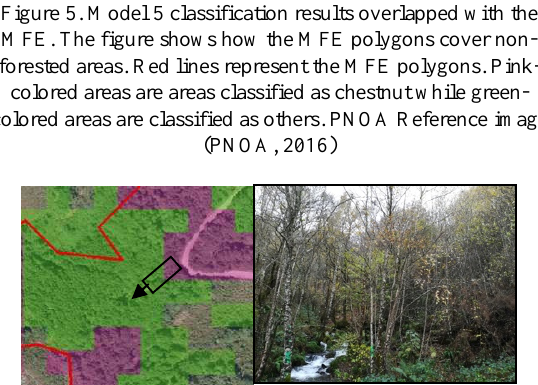
Table 3. Random forest models performance. MR (March), MA (May), J (July), S (September), OA (Overall Accuracy), UA (Users Accuracy), PA (Producers Accuracy), cast (chestnut Figure 6. Left: Model 5 classification results overlapped with class), other (other class). the MFE. Right: Field work picture. The figure shows an example of forest areas wrongly classified as chestnut forest by the MFE. Red lines represent the MFE polygons. Pink-colored areas are areas classified as chestnut while green-colored areas are classified as others. PNOA Reference image (PNOA, 2016)